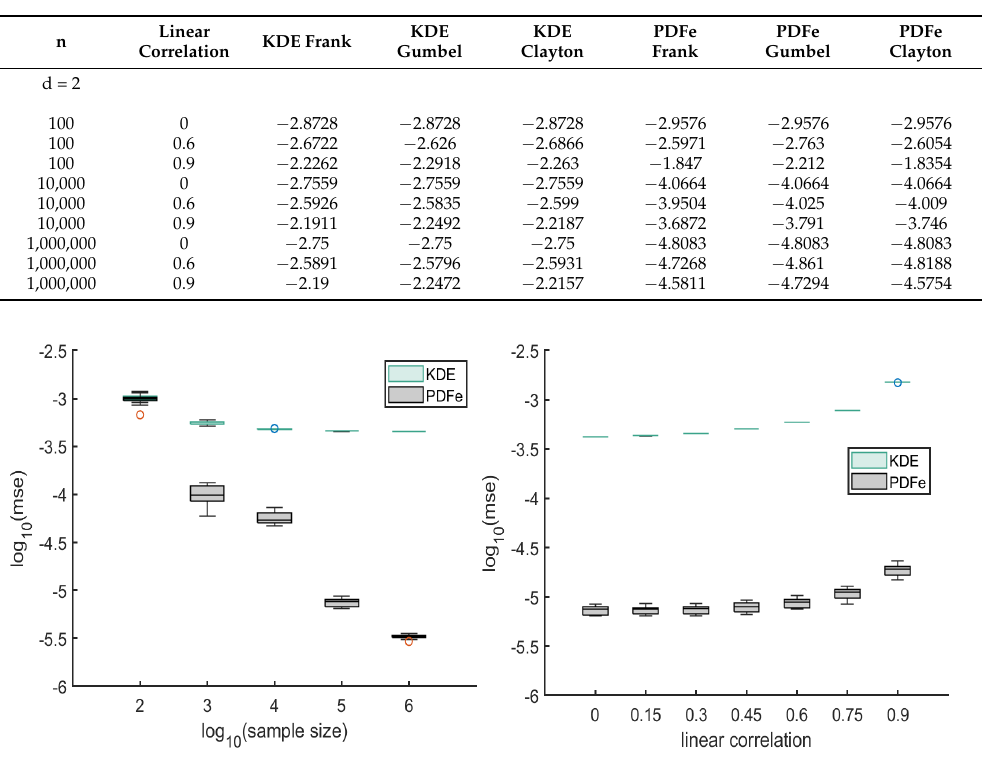
Table 3. Accuracy for synthetic data comparison by copula, measured by mean squared error on a log base 10 scale.